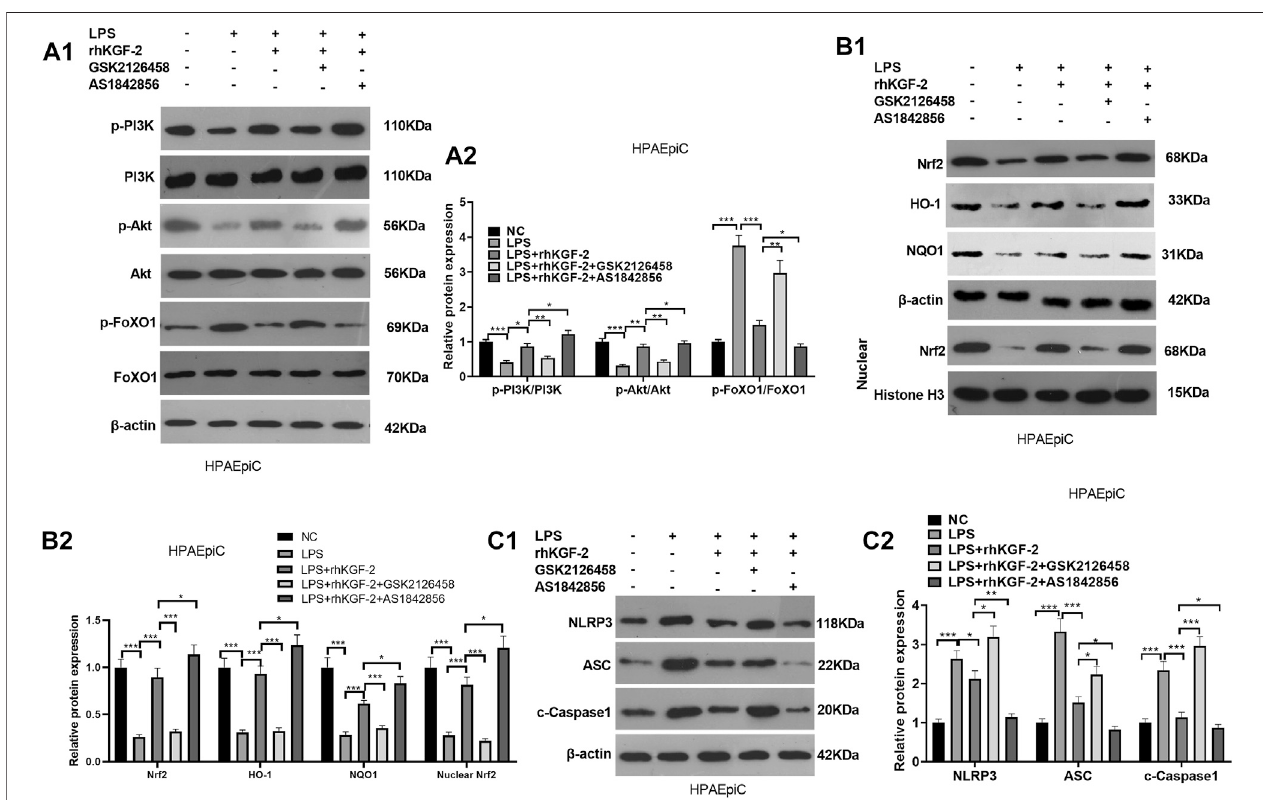
FIGURE4| The effect ofPI3K inhibitor and FoxO1inhibitor on theexpression ofPI3K/Akt,Nrf2/HO-1/NQO1,andFoxO1-NLRP3-ASC-Caspase1in fl ammasome. BEAS-2B cells were treated with LPS (10 μ g/ml), rhKGF-2 (10 ng/ml), GSK2126458 (0.5 nM) and/or AS1842856 (30 nM) for 24 h. A1-A2 : WB was carried out to determinetheexpressionofPI3K/AktandFoxO1inHPAEpiCcells. B1-B2 .TheproteinlevelsofNrf2,HO-1andNQO1intheHPAEpiCcellsornuclearweredetectedby WB.NuclearNrf2wascalculatedusingHistoneH3asinternalcontrol. C1-C2 .WBwasconductedtodetectNLRP3-ASC-Caspase1inHPAEpiCcells.Therelative proteinexpression( Y -axis)wascalculatedasfoldchangeofNCgroup.Dataareexpressedasmean ± SD.Allexperimentswererepeatedforthreetimes.Datadifference was analyzed via ANOVA, and Student ’ s t test. * p ＜ 0.05, ** p ＜ 0.01, *** p ＜ 0.001. N (cid:2)